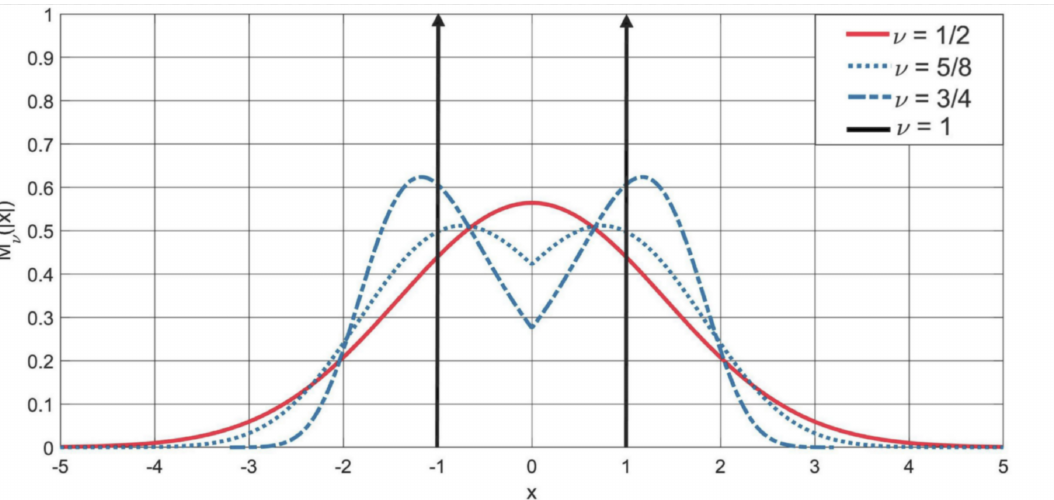
Figure 5. Plot of the symmetric M -Wright function M ν ( | x | ) for 0 ≤ ν ≤ 1/2. Note that the M -Wright function becomes a Gaussian density for ν = 1/2.